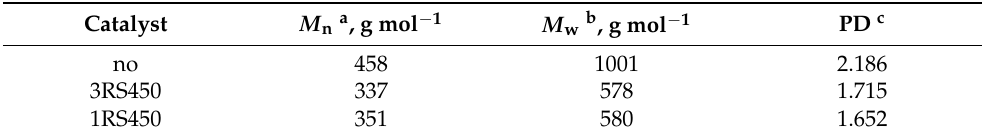
Figure 7. The effect of Ru content on the yield and composition of the gaseous products of spruce wood RCF at 225 ° С for 3 h. 0246 8 10 12